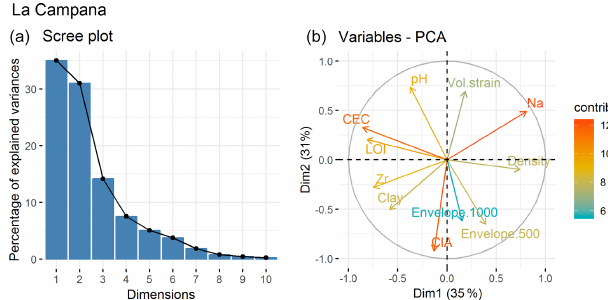
Figure 9. Principal component analysis (PCA) of properties for all four pedons in La